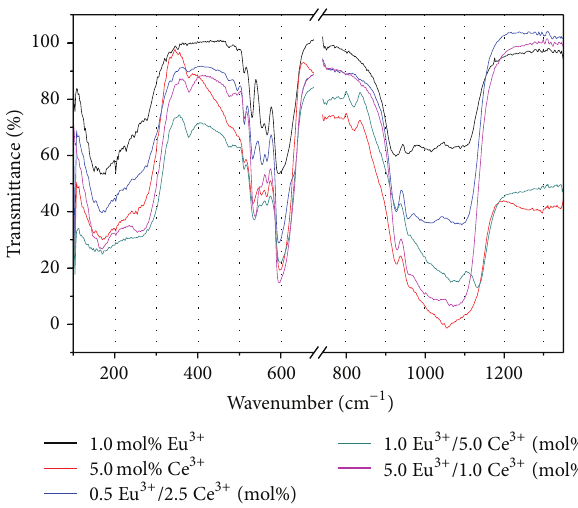
Figure 4: FTIR spectra of all the synthesized samples.